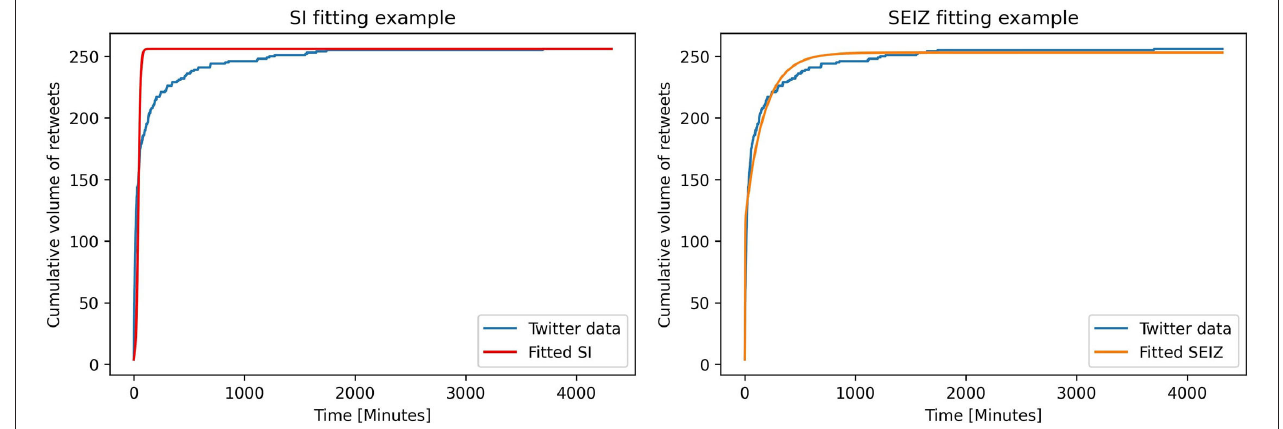
FIGURE 2 | SI and SEIZ fitting examples for the first 72h of diffusion of a particular rumor.